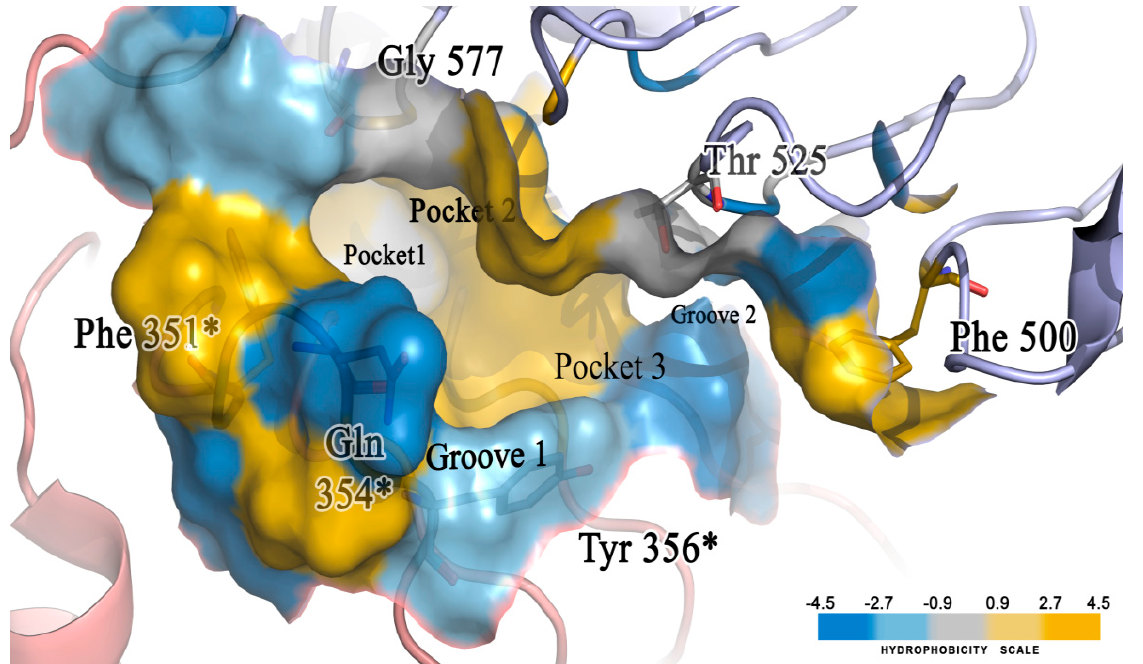
Figure 16. The binding pocket of TLR7 protein. The blue color represents low hydrophobicity, and the yellow areas represent highly hydrophobic regions with intermediates indicated in grey. * represents the residues of chain B of the homodimeric protein.